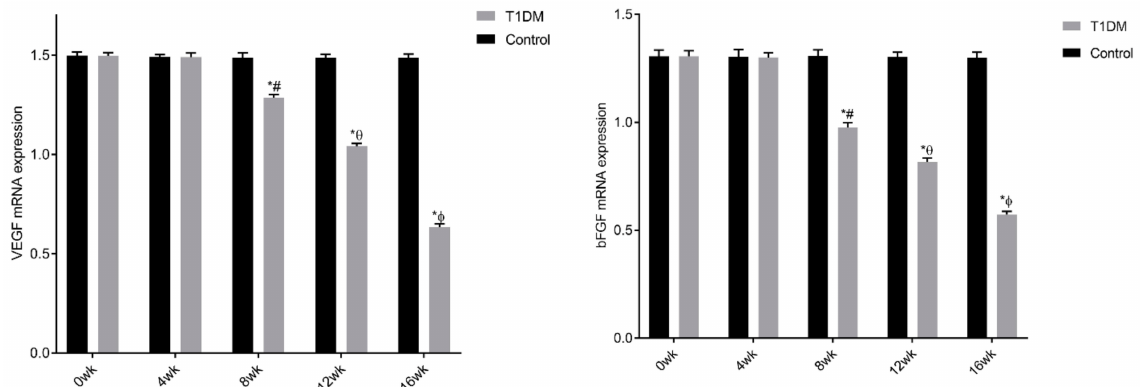
Figure 7. The mRNA expression of VEGF and bFGF in ADSCs. The mRNA expression of VEGF and bFGF was downregu- lated at 8, 12, and 16 weeks in T1DM group compared with control group at the same time point. *, p < 0.05. The mRNA expression of VEGF and bFGF continued to downregulate with the prolongation of the course of diabetes. #, p < 0.05, vs. 4 weeks of T1DM. θ , p < 0.05, vs. 8 weeks of T1DM. Φ , p < 0.05, vs. 12 weeks of